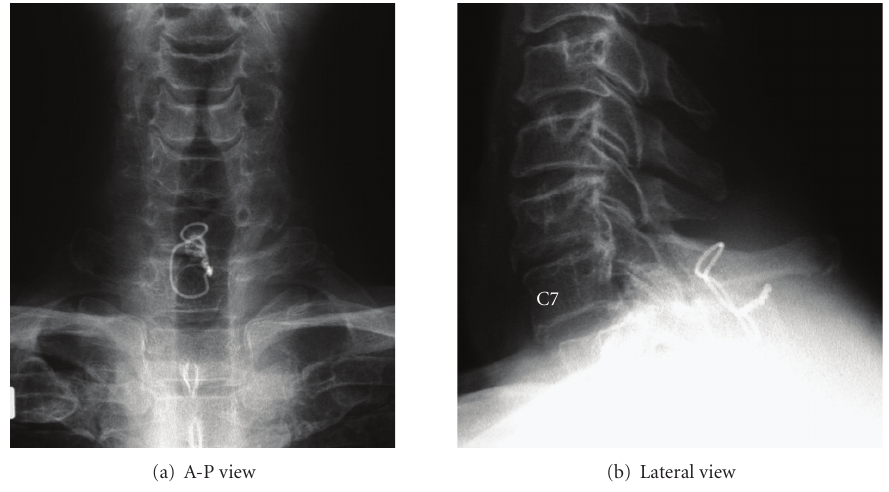
Figure 5: Radiographs one year